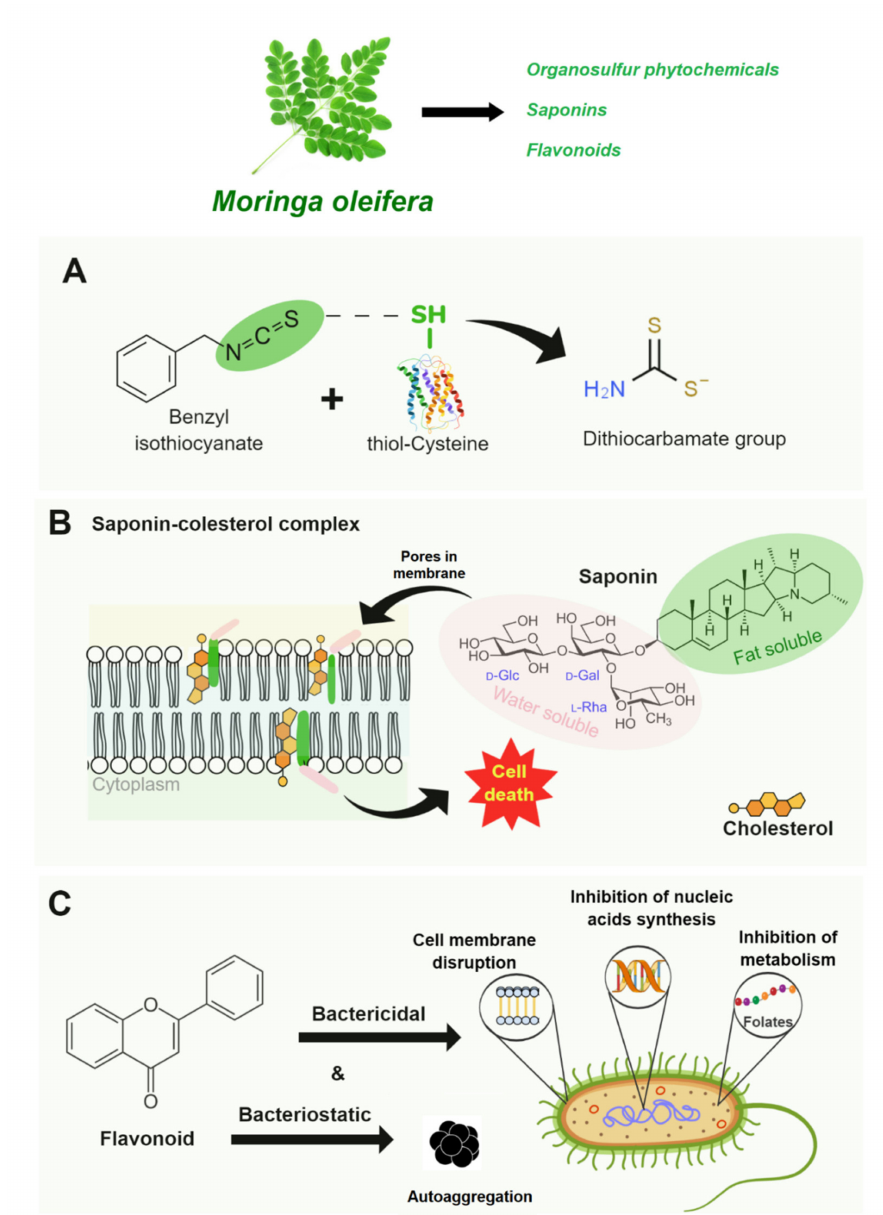
Figure 2. Antimicrobial mechanisms of Moringa oleifera bioactive compounds: ( A ) Protein damage- triggered by benzyl isothiocyanates bioconjugation with cysteine. ( B ) Membrane dysfunction- triggered by saponins complex formation with cholesterol. ( C ) Bacteriostatic and bactericidal effects of